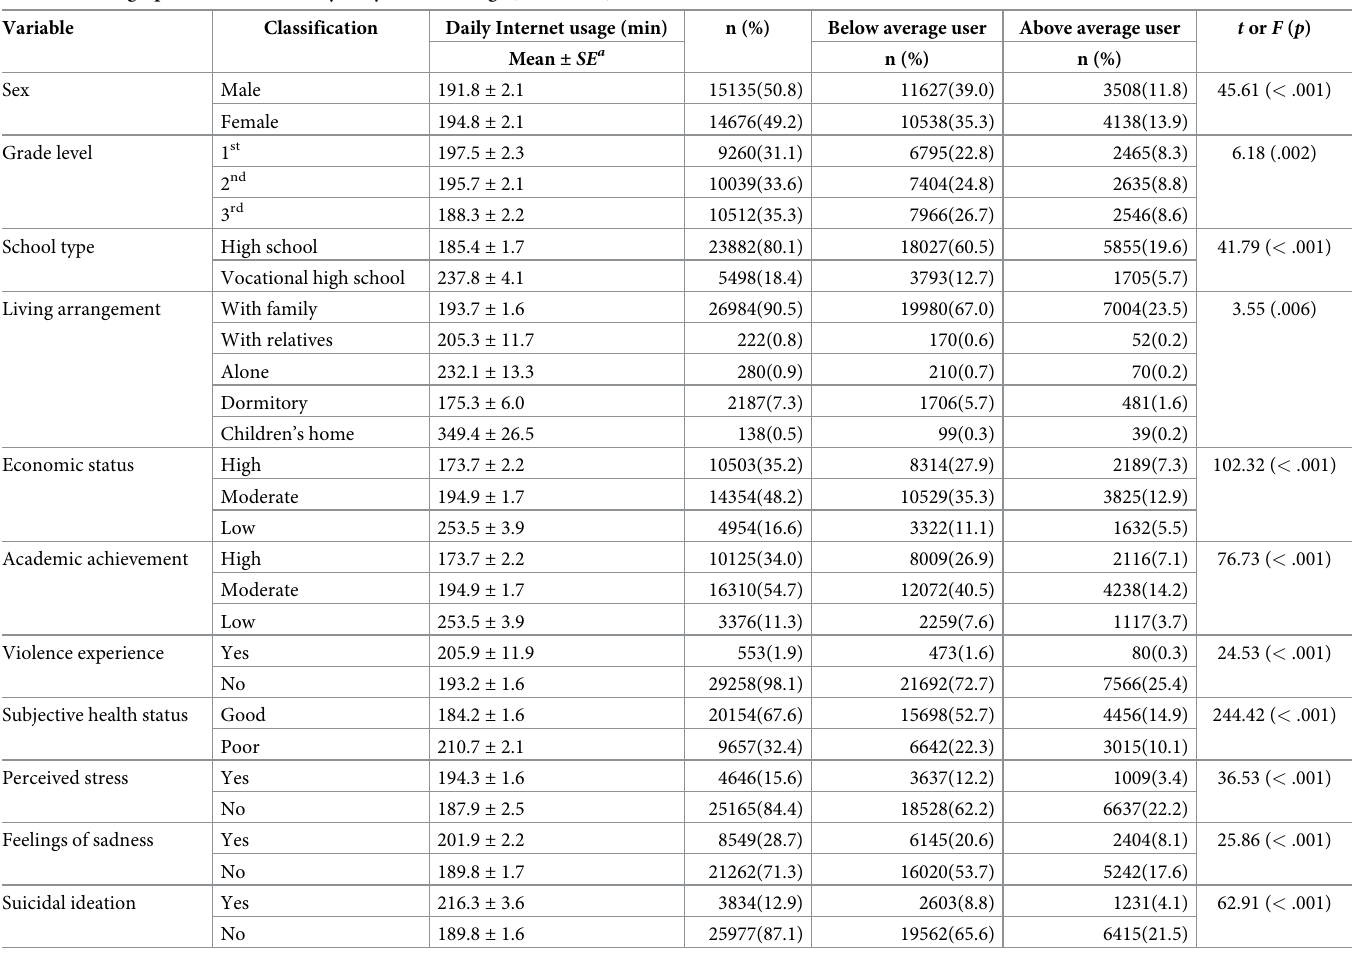
Table 1. Demographic characteristics by daily Internet usage (N =